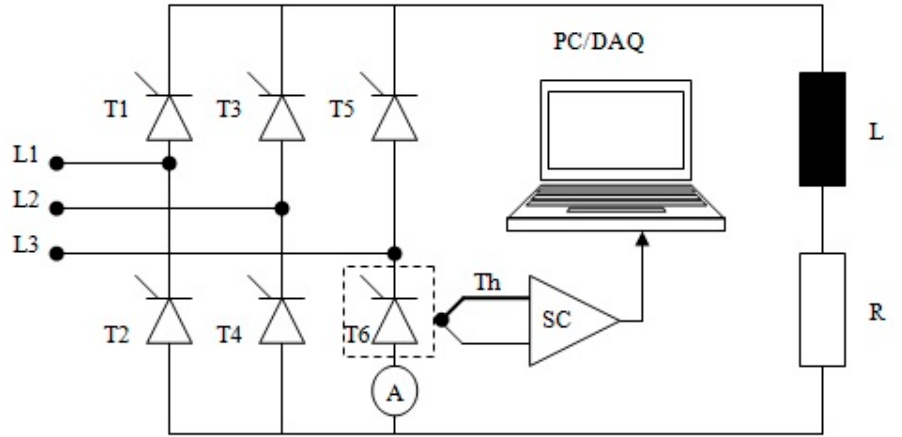
Figure 17. The Device Under Test experimental setup.